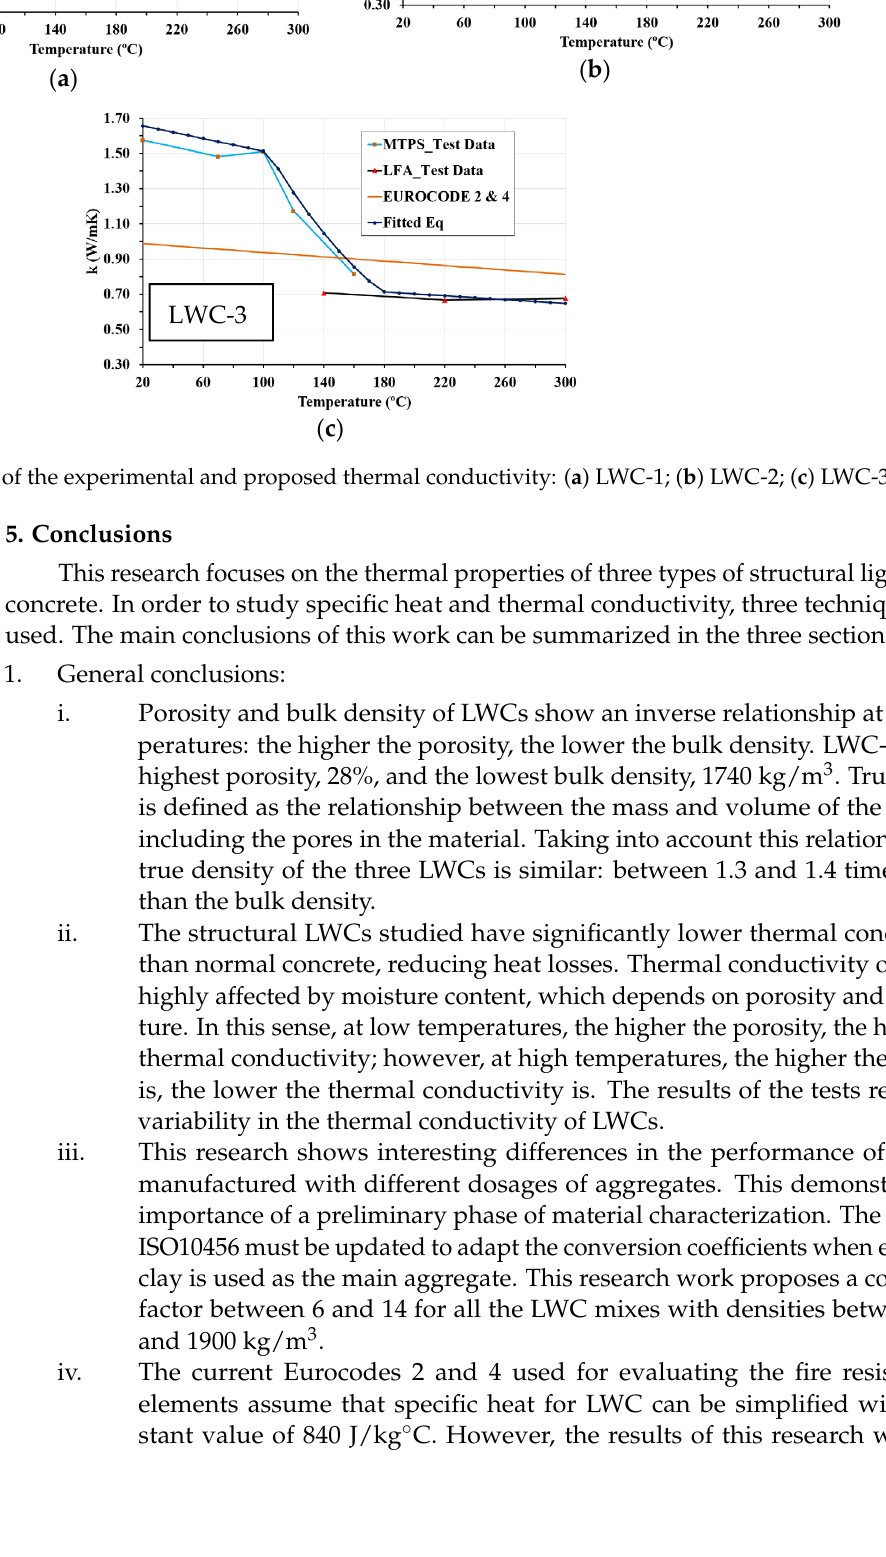
( b ) Figure 10. Specific heat: ( a ) comparison of the experimental and proposed specific heat equations; ( b ) comparison of proposed equations, simplified equation, and Eurocodes 2 and 4 values. 4.2. Thermal Conductivity Equations Data generated from the thermal conductivity measurements are used to develop thermal conductivity relationships for LWC. This thermal property is expressed in the form of empirical relationships in the temperature range of 20–300 °C. A good relation was found between the experimental and the statistical model, as noted by R 2 , whose value lay between 0.9 and 1. The test data clearly indicate that thermal conductivity is mainly influenced by the porosity of LWC and the temperature range. To reflect this trend, separate expressions are developed for thermal conductivity. Thermal conductivity relationships are presented in three temperature ranges: 20–100, 100–180, and 180–300 °C. These relations are presented in Equations (21)–(23). 𝑘(𝑇) = 𝜌 (cid:2870)(cid:2868)°(cid:2887) × (9.4 ⋅ 10 (cid:2879)(cid:2872) [ (cid:2907)(cid:2923) (cid:3118) (cid:2921)(cid:2917)°(cid:2887) ] − 10 (cid:2879)(cid:2874) [ (cid:2907)(cid:2923) (cid:3118) (cid:2921)(cid:2917)°(cid:2887) (cid:3118) ] × 𝑇( ° C)) ( R 2 = 0.9)